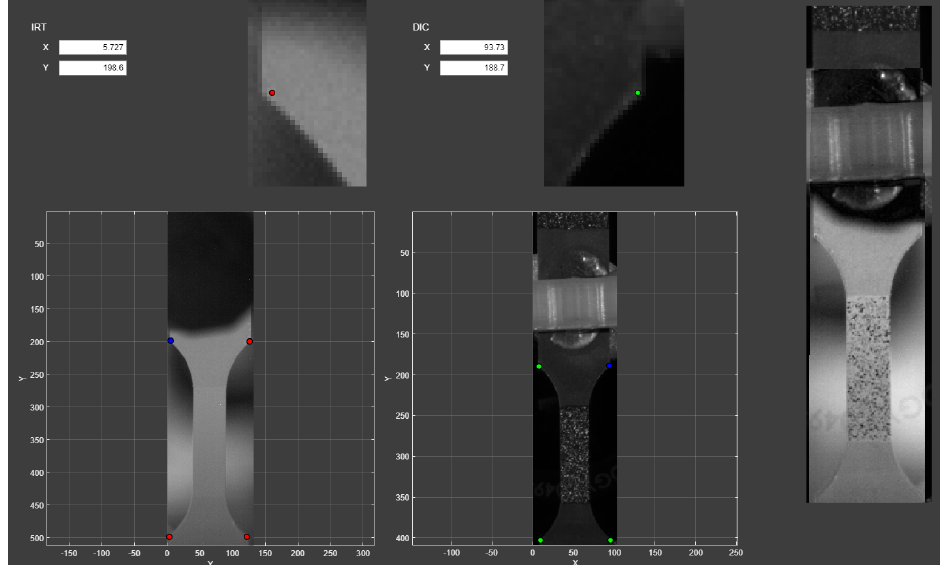
Figure 4. Graphical software used to find the transformation matrix; the coloured points are the operator–chosen reference